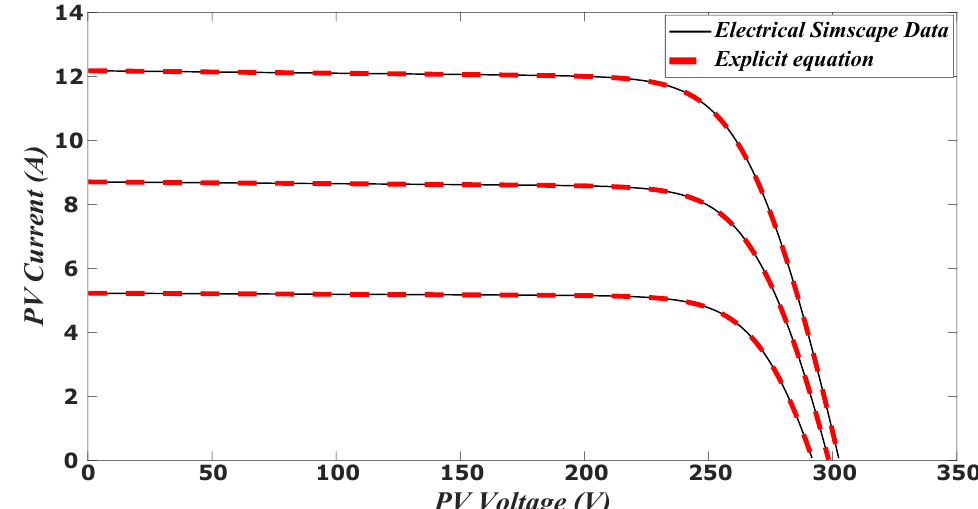
Figure 3. Comparison of the Simscape data and the explicit Single-Diode Model (SDM) with different irradiance levels.